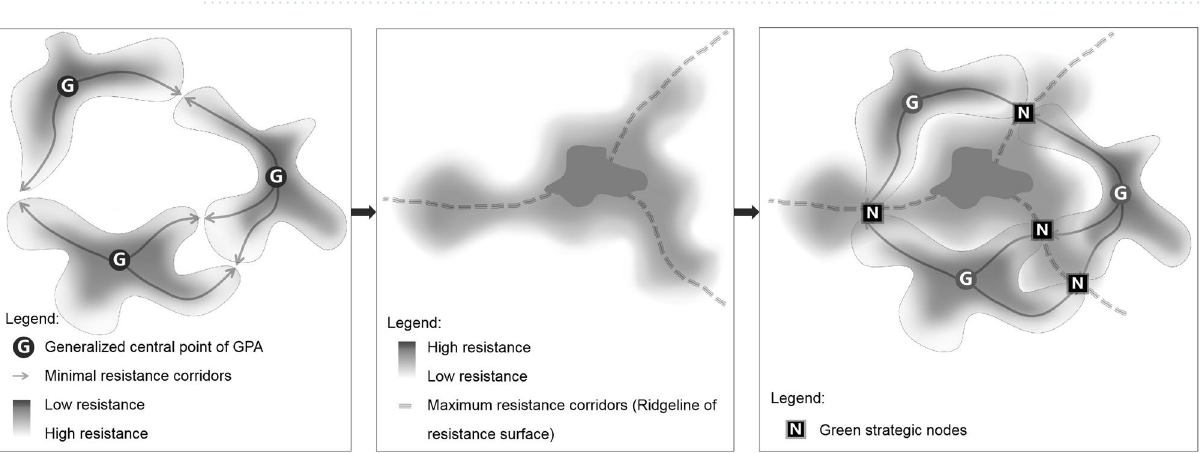
Figure 11. Recognition methods of the minimum–maximum value